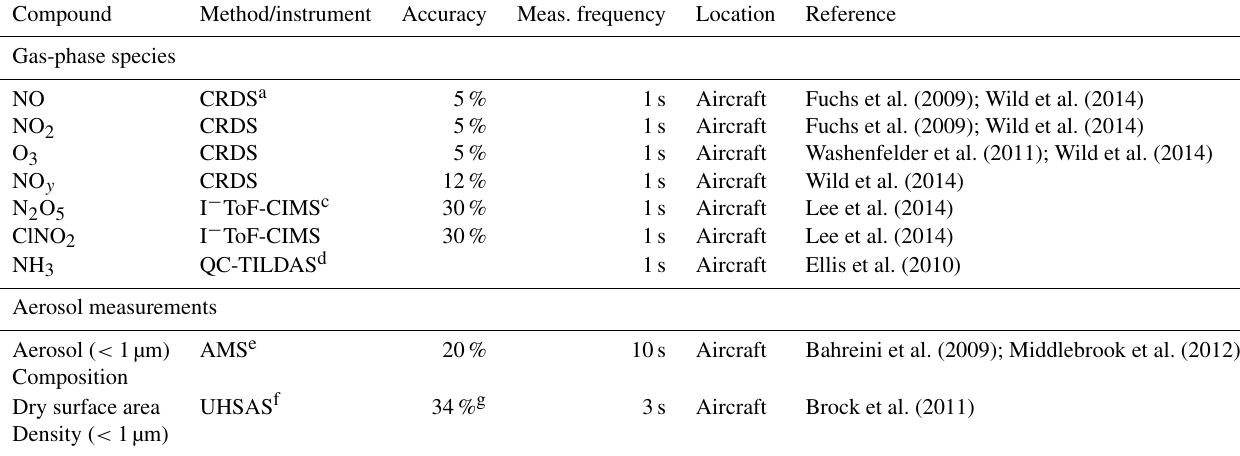
Table 1. Aircraft measurements used in this analysis. Compound Method/instrument Accuracy Meas. frequency Location Reference Gas-phase species